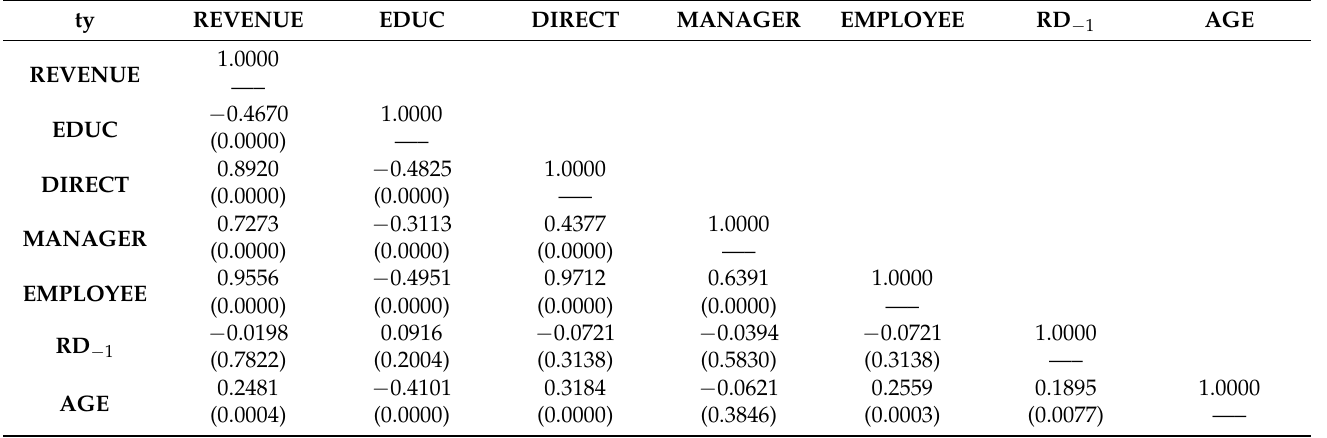
Table 4. Correlation matrix for dependent and independent variables ( p –values in